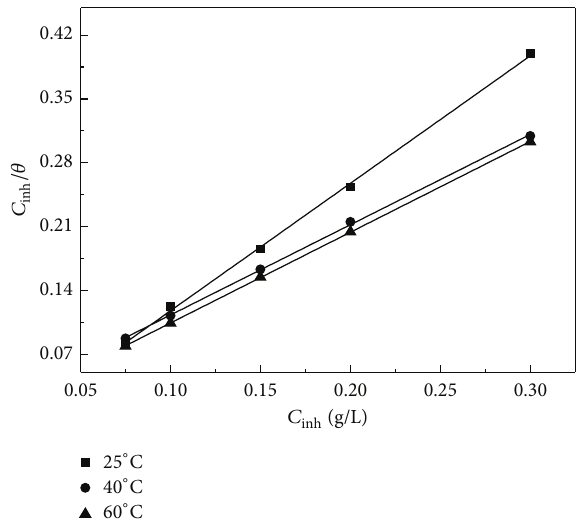
Figure 9: Langmuir type of adsorption for carbon steel in presence of Opuntia ficus-indica .